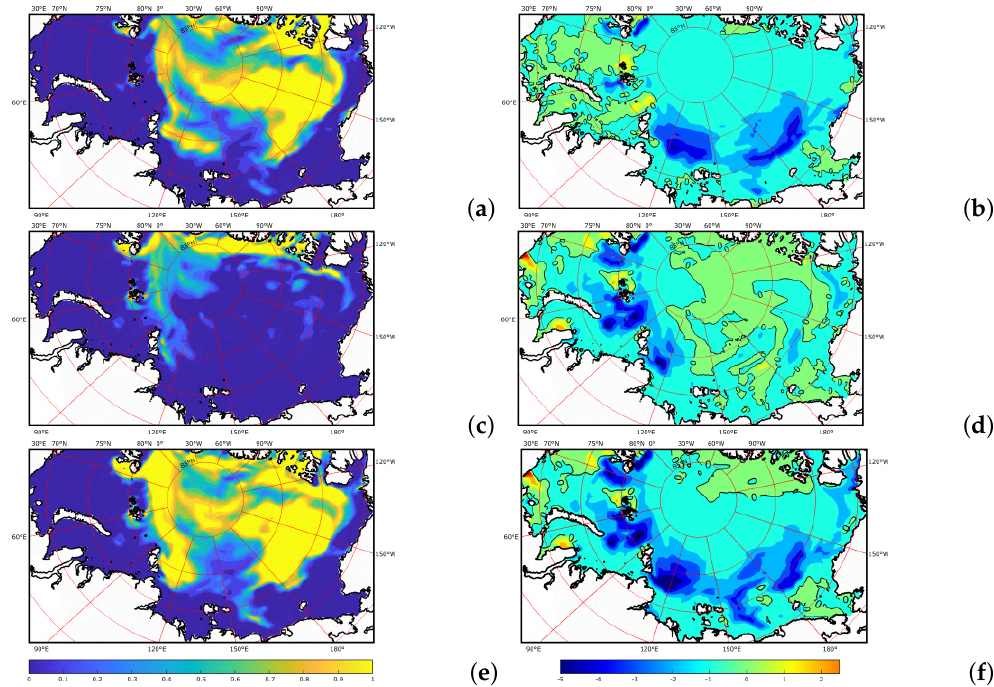
Figure 18. Sensitivity to initial state of sea ice and ocean during one year. Difference in simulated fields in September 2020. (B1-A0)-( a , b ); (B2-A0)-( c , d ); (B3-A0)-( e , f ) in ice thickness (in m)-( a , c , e ) and SST (in ◦ C)-( b , d , f )